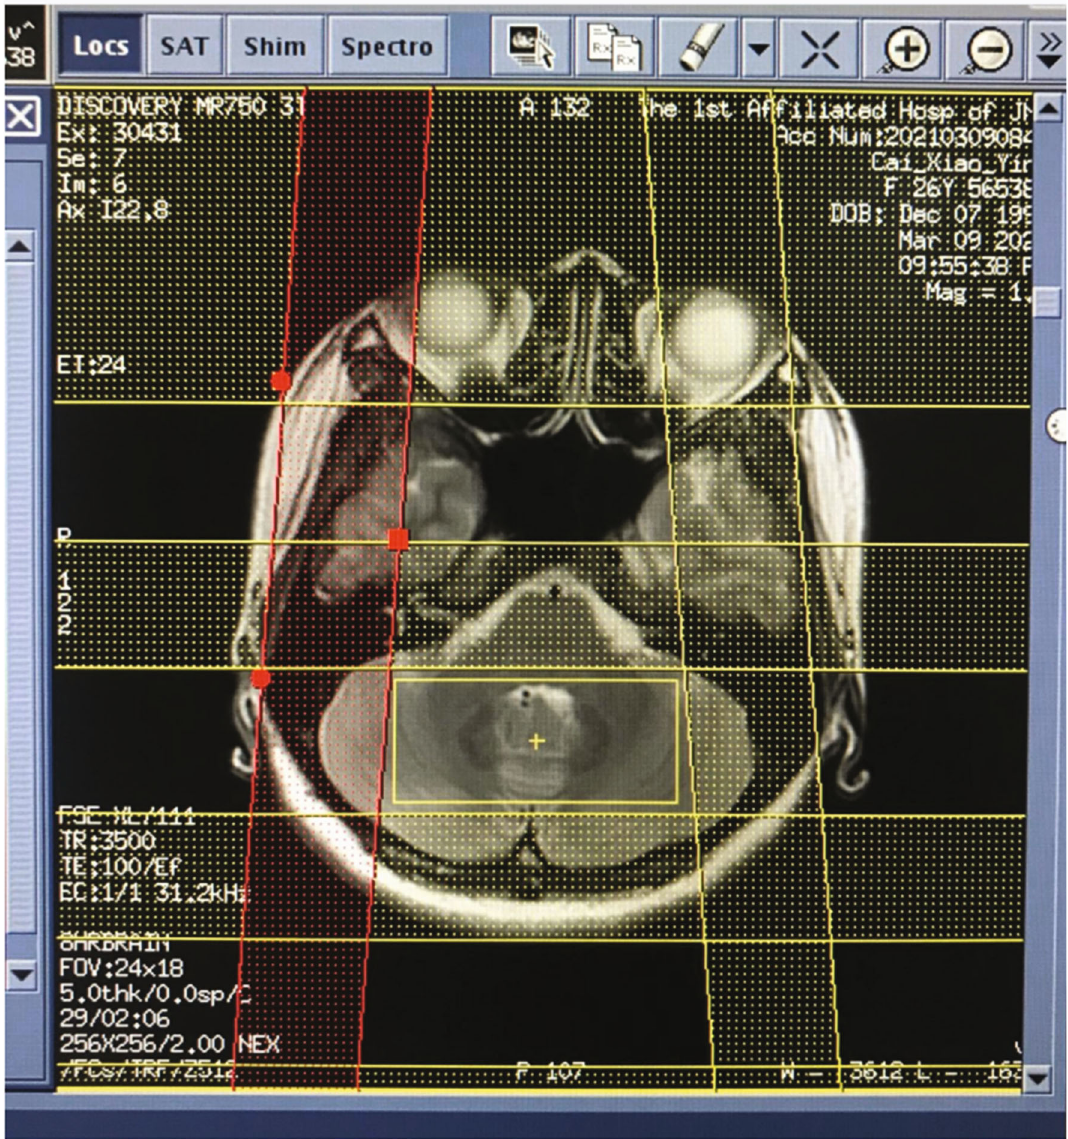
Figure 3: “ Saturation bands ”